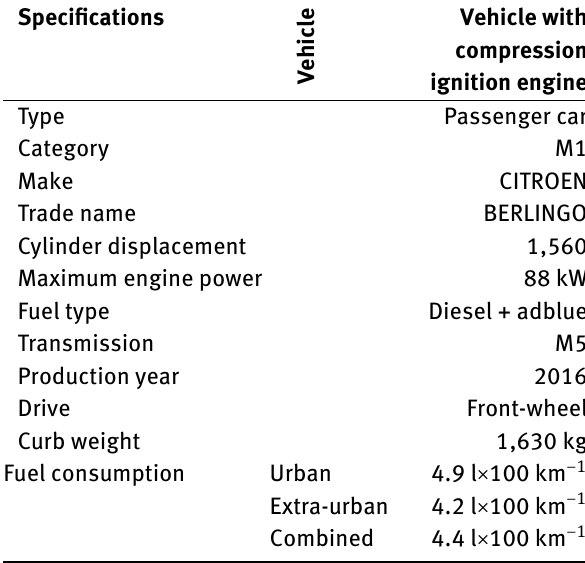
Table 1: Specifications of vehicle used for